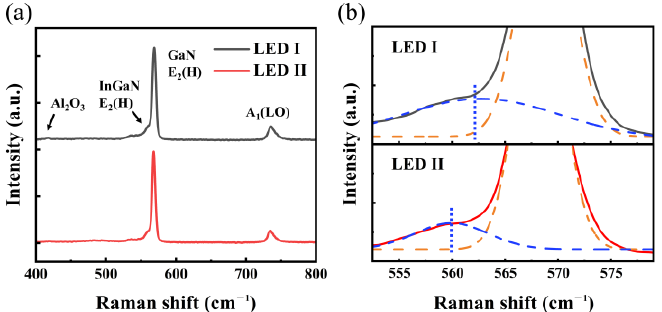
Figure 4. ( a ) Raman spectra for LED I and LED II. ( b ) Enlarged view of the E 2 (H) mode peak. Blue and orange dashed lines show the separated InGaN and GaN E 2 (H) modes, respectively.